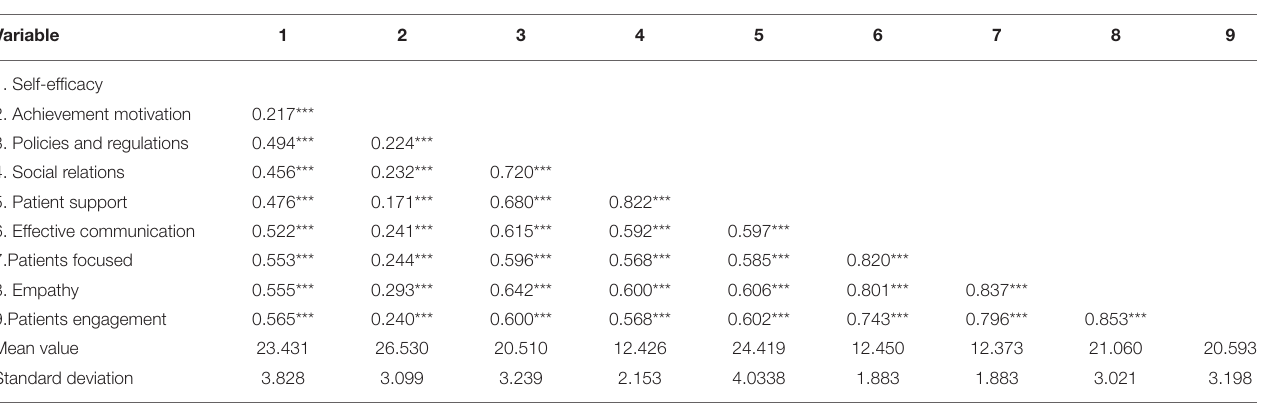
TABLE 3 | Mean, standard deviation, and correlation coefficient of each variable ( N = 1,612).